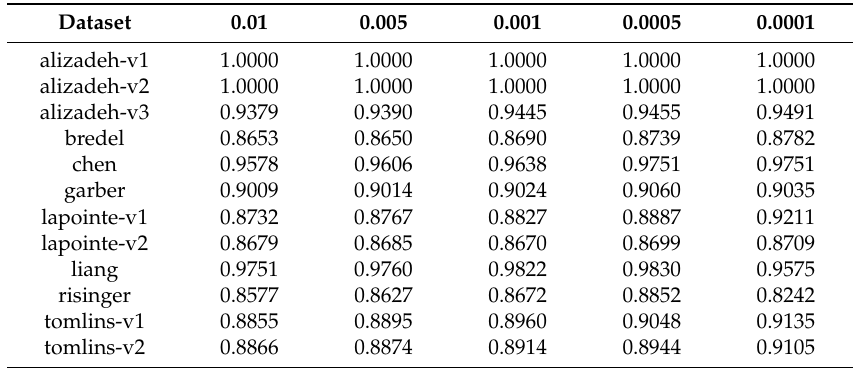
Table 2. Accuracies of a voting-based extreme-learning machine (V-ELM) under different